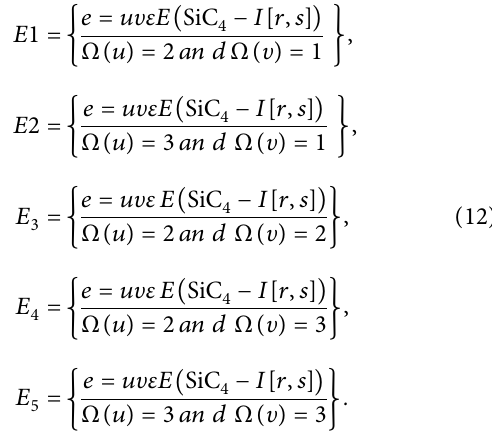
Figure 2: (a) contains a single row of silicon structure SiC − I [ 3 , 2 ] connected by red lines structure SiC 4